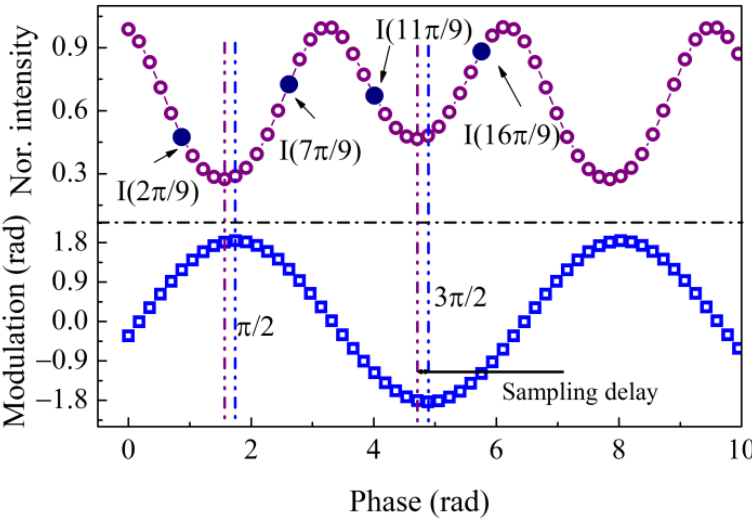
Figure 2. Modulation and discrete sampling of the normalized interference signal. Define that